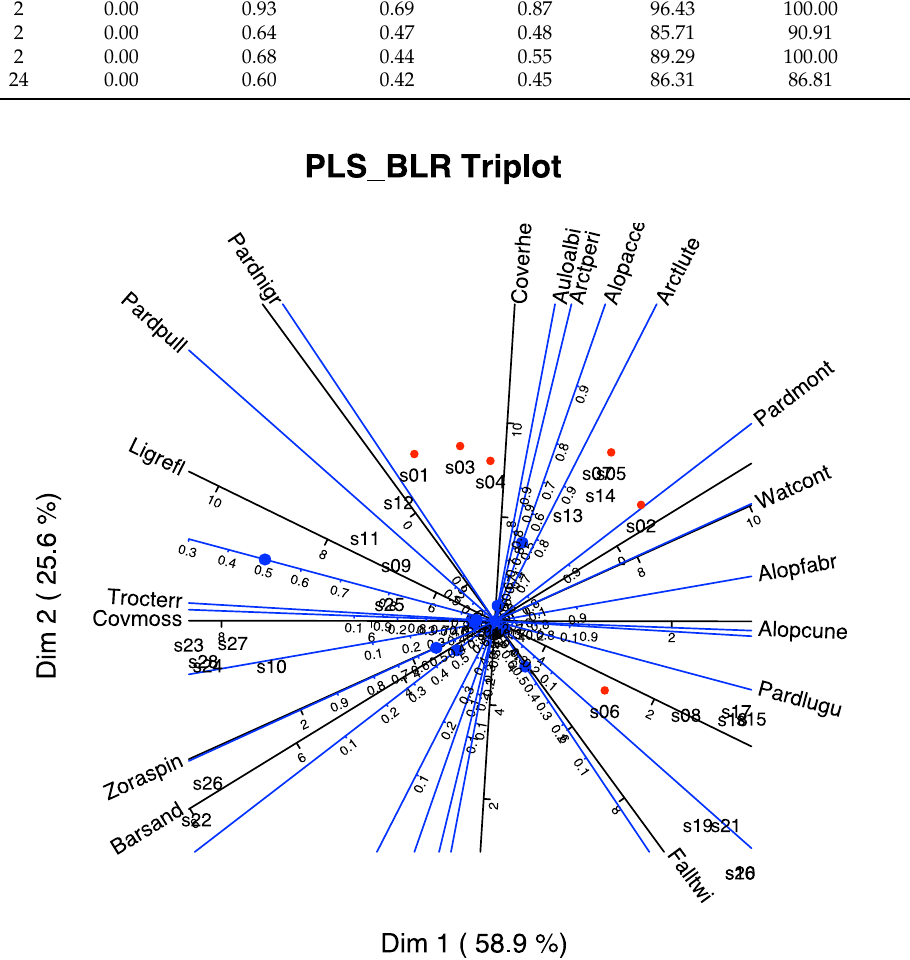
Figure 10. PLS-BLR Triplot for the spider data with scales for the variables. Finally, we show the prediction regions for each response separately (Figure 12). In the graph, the points with observed presences have been represented in blue, the star joins each point with the centroid of the presences. The absences have been coloured in red. As before, the dotted line is the direction that best predicts the expected probability, and the arrow shows the direction of increasing probabilities. The perpendicular line is the separation between the regions predicting presence and absence, the side of the arrow being the prediction of presence. We can see that most of the observed values lie in the correct prediction regions. This means that the proposed technique correctly captures the structure of the data and the relations among species and environmental